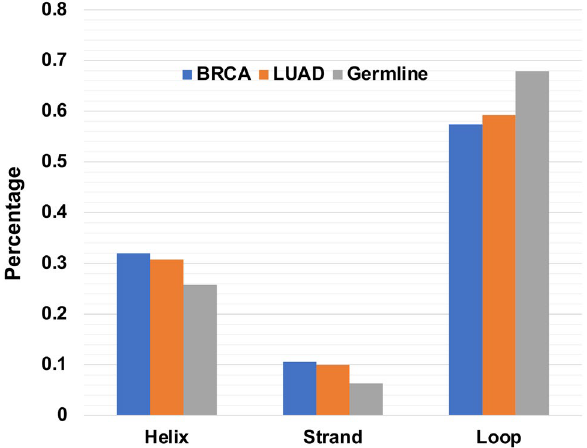
Figure 1. Distribution of secondary structure types of somatic NFS indels and germline NFS indels.